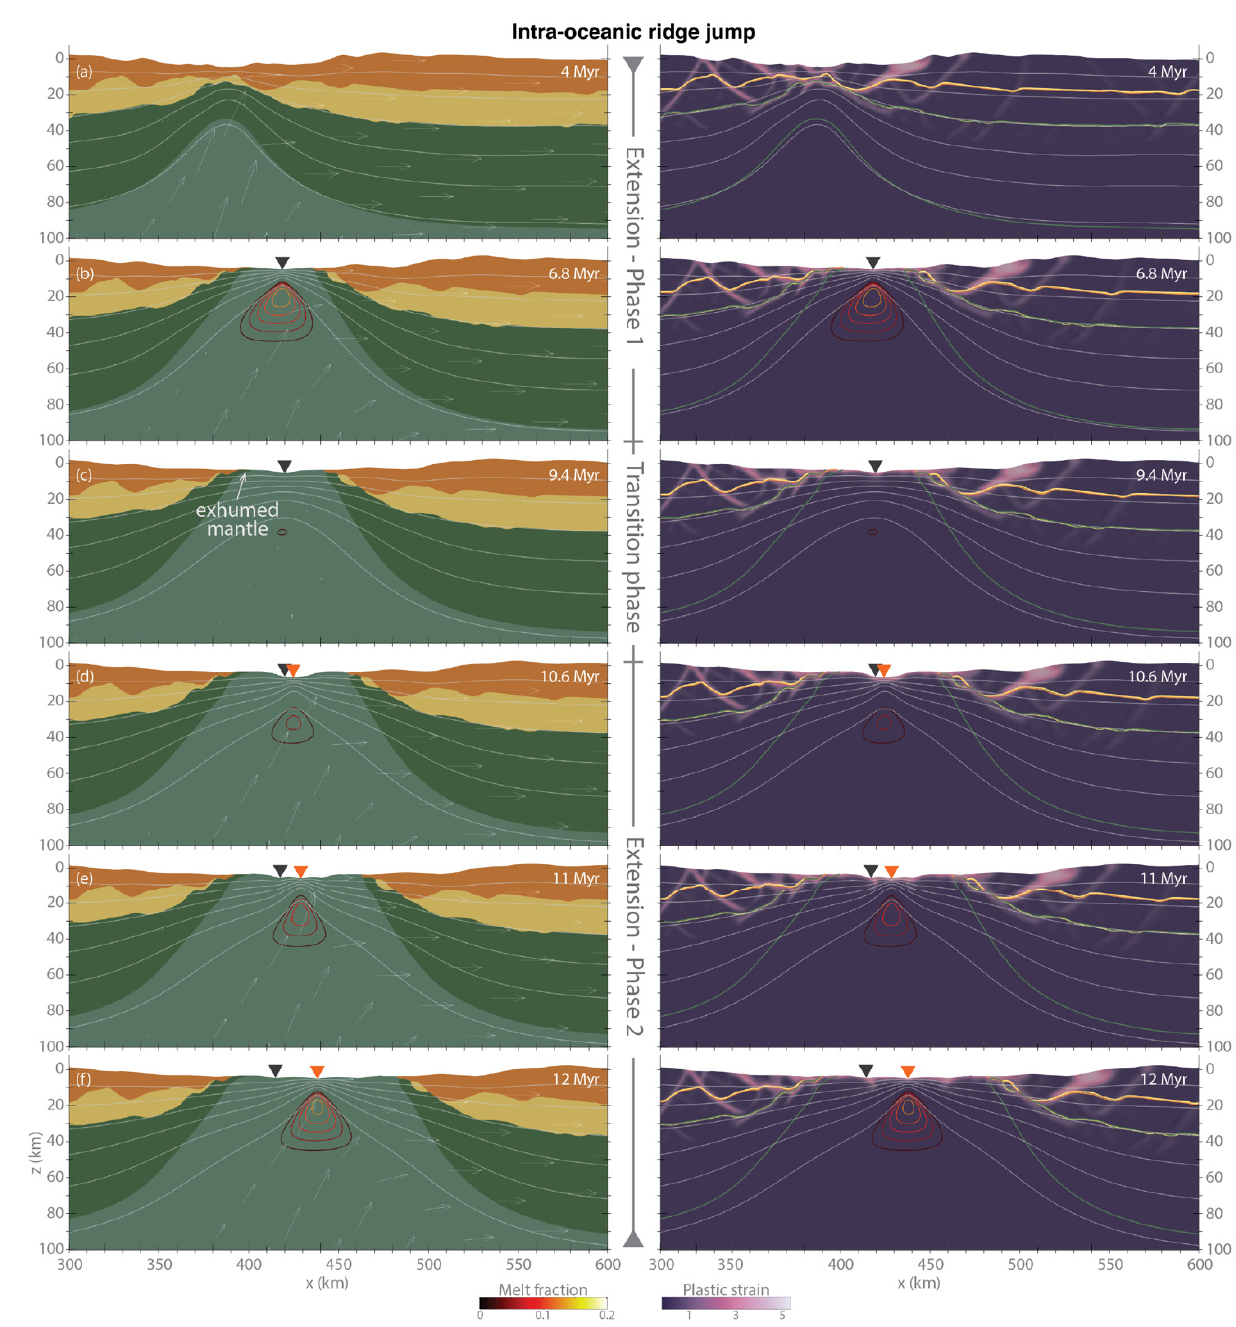
Figure 5. Intra-oceanic ridge jump. Evolution of model with v 1 = 2 cm/yr, v 2 = 2 cm/yr, and t 1 = 7 Myr. Left column shows the compositional field (see Figure 2 for legend) and right column shows the non-initial plastic strain field. Snapshots ( a , b ) are similar to those of Figure 3, with continental lithospheric thinning, break-up, exhumation of lithospheric mantle, and formation of a spreading ridge occur. ( c ) Pause in extension, from 7 to 10 Myr, tapers melt production, until no melt is formed. ( d ) After extension is resumed adiabatic decompression melting starts again and ( e , f ) a new spreading ridge forms slightly offset towards the trench, but very close to previous spreading ridge location. At the end of the model, the basin is made of exhumed mantle material on the right margin and new oceanic crust everywhere else. When melt is present, contours of melt fraction are shown. Isotherms are plotted every 200 ° C. Black triangles show the location of the first spreading ridge, while orange triangles show the location of the spreading ridge during the second phase of extension. Figure S3 in the supplementary material shows the effective viscosity for the same time steps.